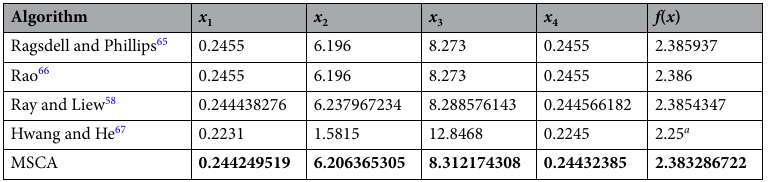
Table 15. The best solution for welded beam design problem on version I. a means infeasible. Significant values are in bold.